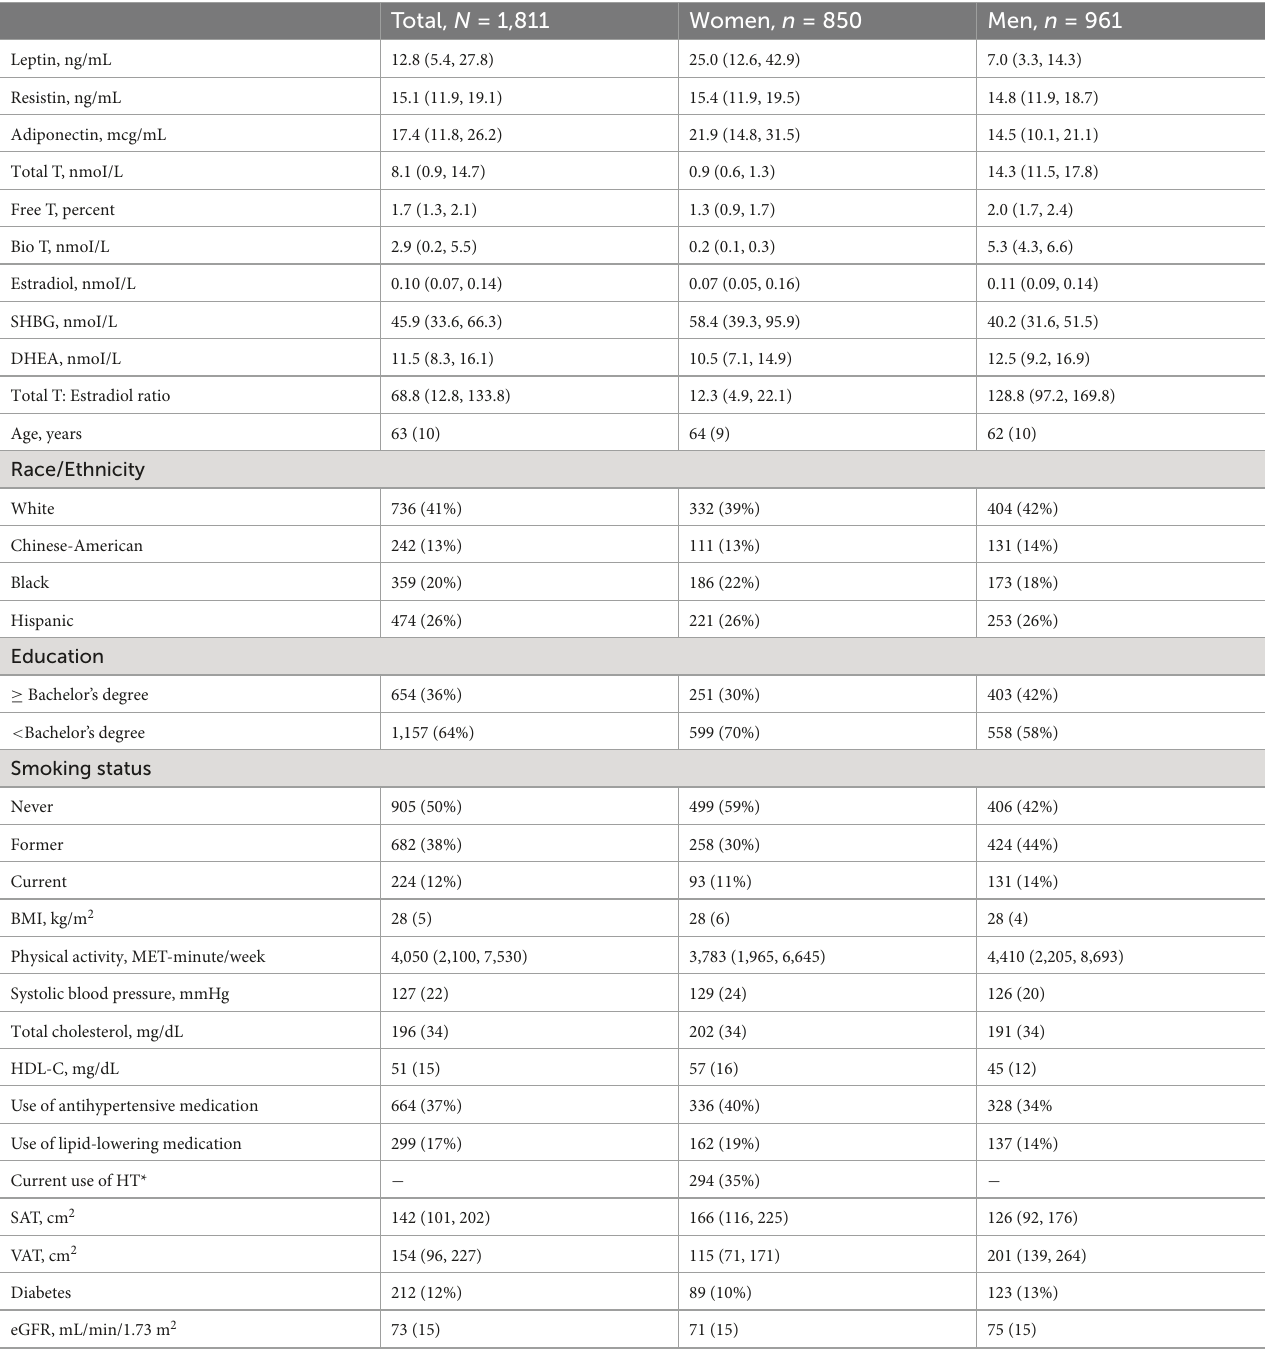
TABLE 1 Characteristics of study